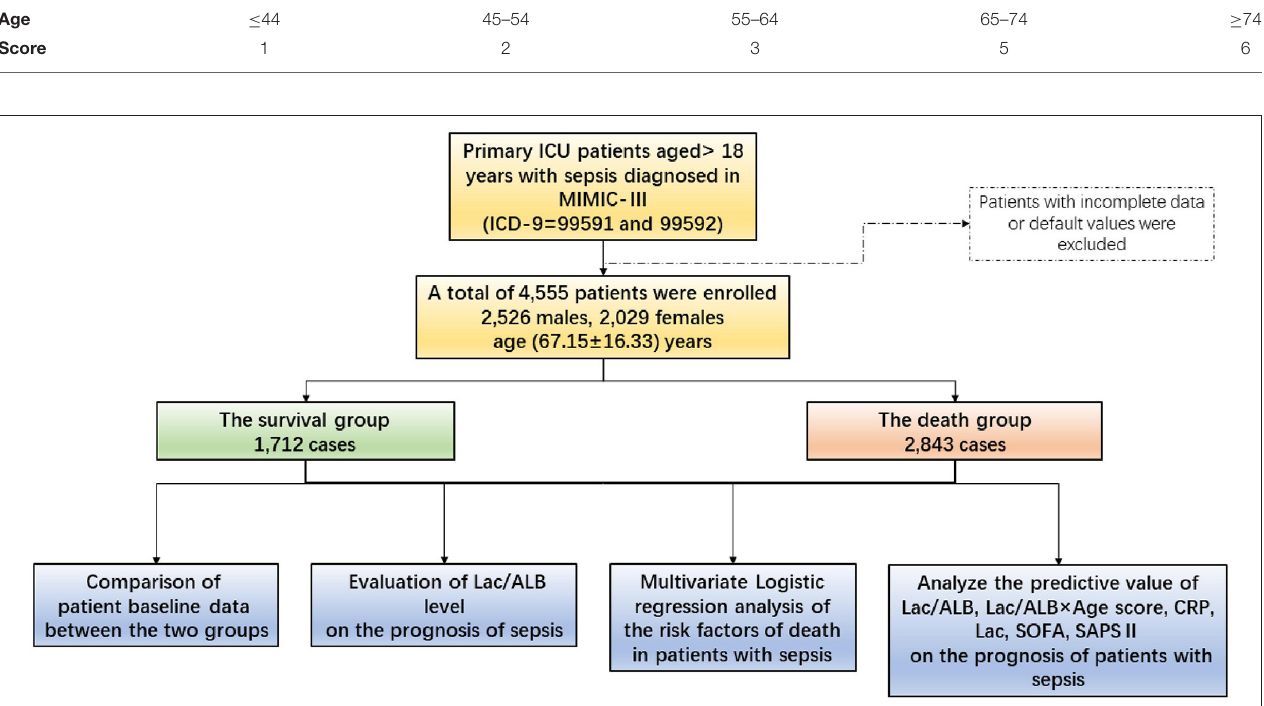
TABLE 1 | Age stratification and score of patients.